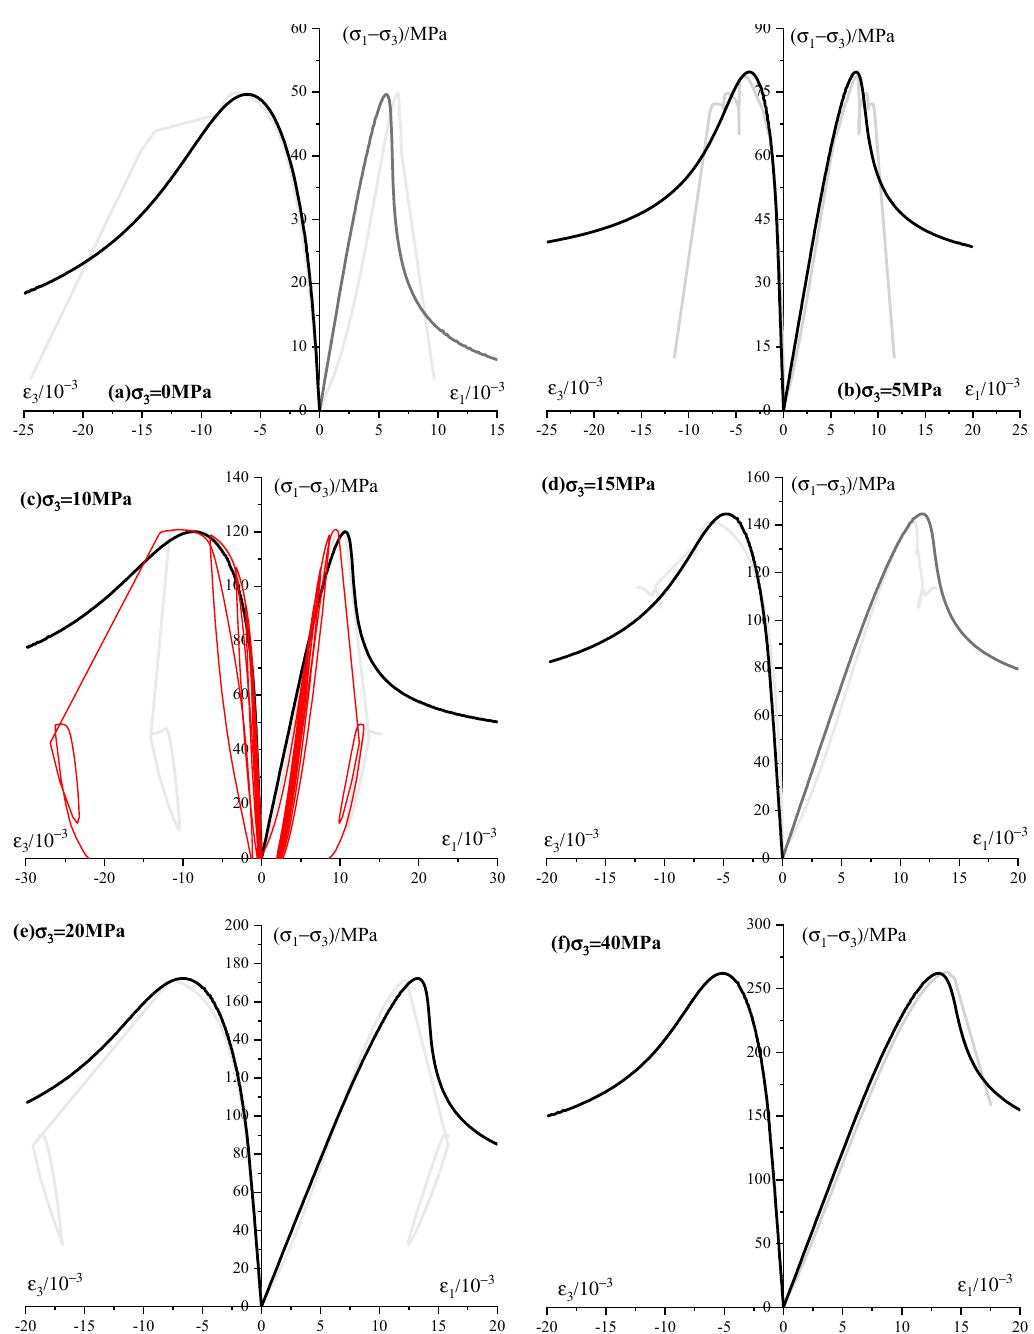
Figure 12. Model results (black) compared to experimental responses (grey). The cyclic experimental results are shown in red, the left is stress–radial strain curves and the right is stress–axial strain curves.